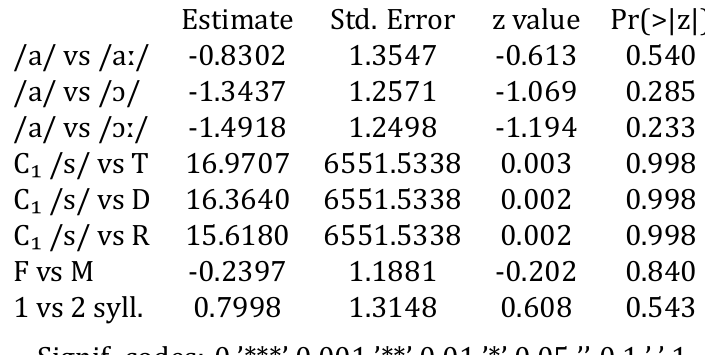
Table A.15: Breathiness occurrence prior to C₂ /s/ as a dependent variable